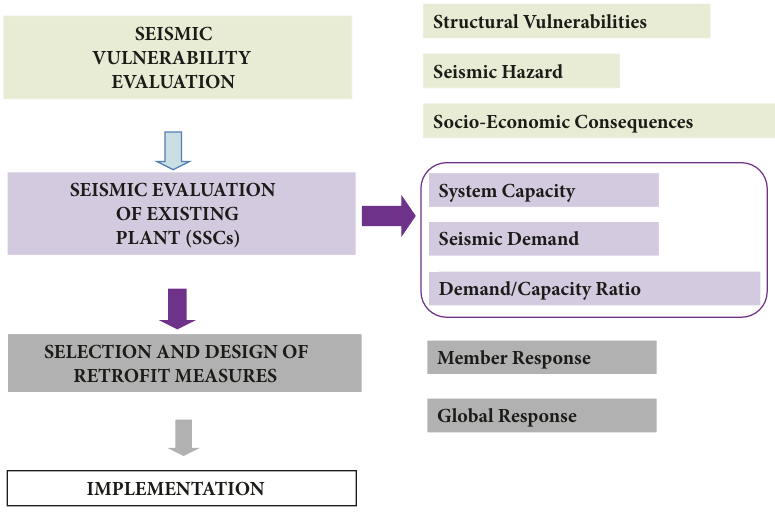
Figure 3: Methodology to evaluate actual performance of nuclear